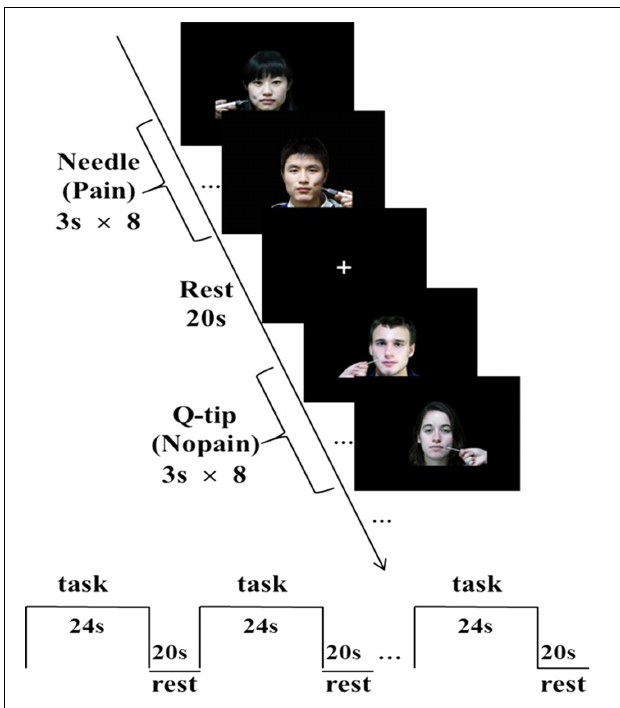
FIGURE 1 | Sample stimuli and fMRI experimental design. A block design was applied. Each block consisted of eight trials. Each 3-s trial depicted either ingroup or outgroup members from the same or difference race receiving painful (needle) or non-painful (Q-tip) stimulation, applied in either the left or the right